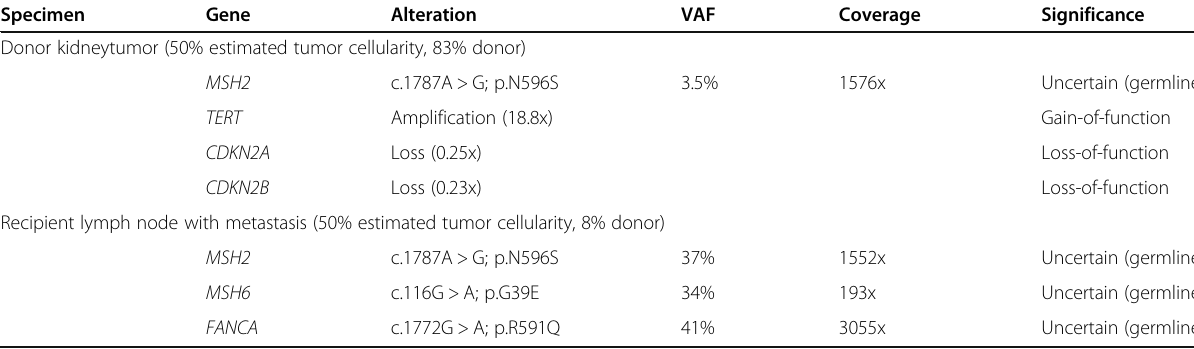
Table 1 Mutation Profiling by Next Generation Sequencing (NGS) Specimen